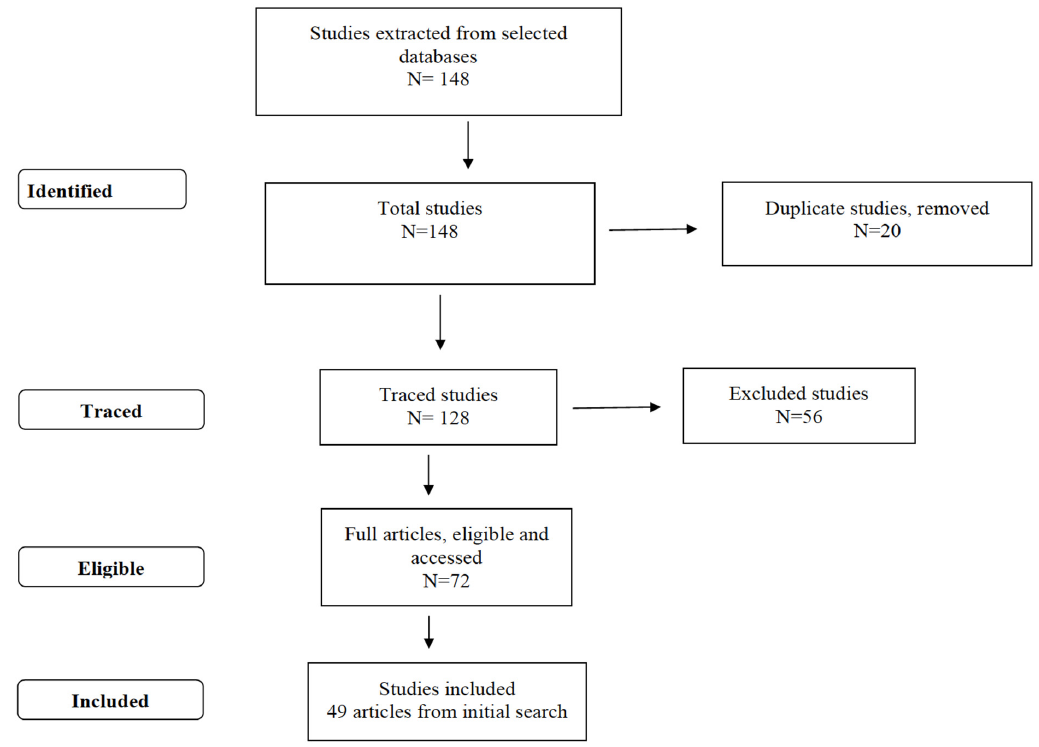
Figure 1. Study selection flowchart.